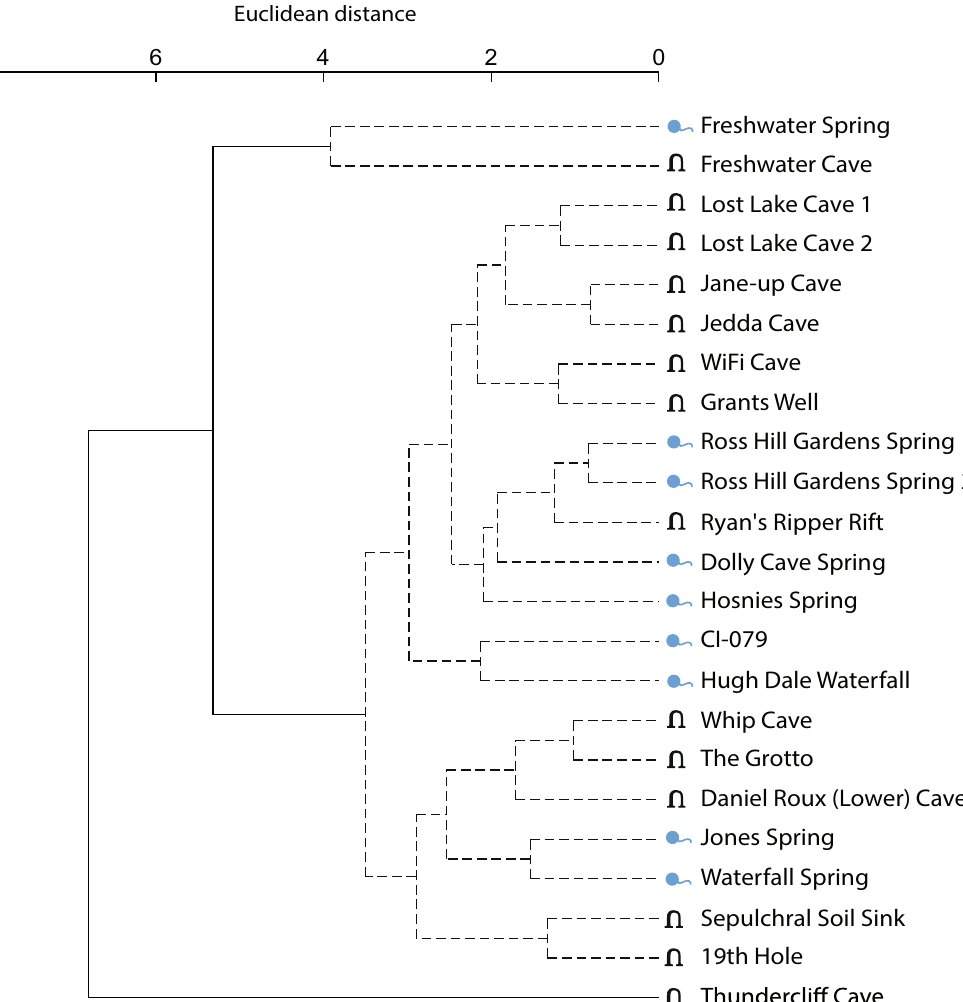
Figure 6. Cluster analysis of CI abiotic environmental similarity. Environmental data incorporated into this analysis included acidity, temperature, salinity, dissolved oxygen, latitude and longitude readings taken from each site at the time of sample collection. Solid lines indicate groups that the SIMPROF analysis identified were significantly different from each other ( P <